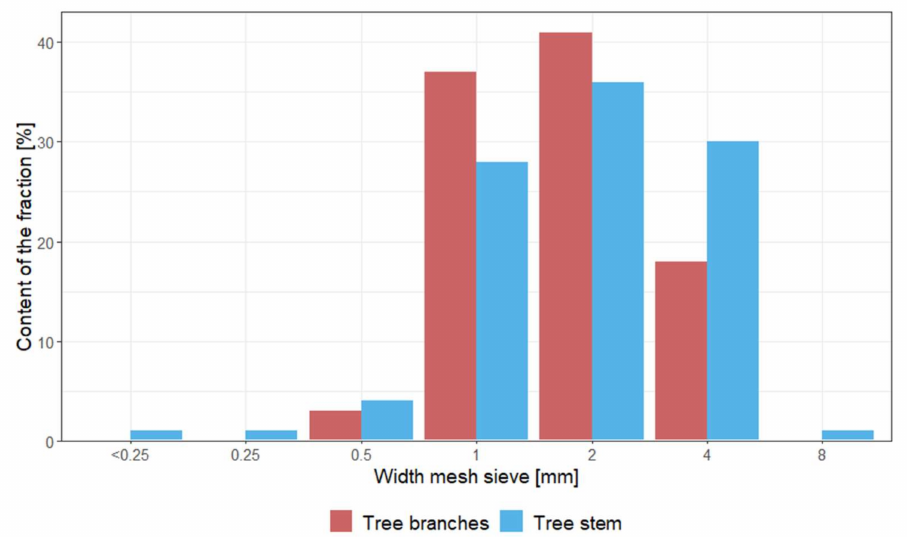
Figure 2. Fractional composition of particles from tree stem and branches.